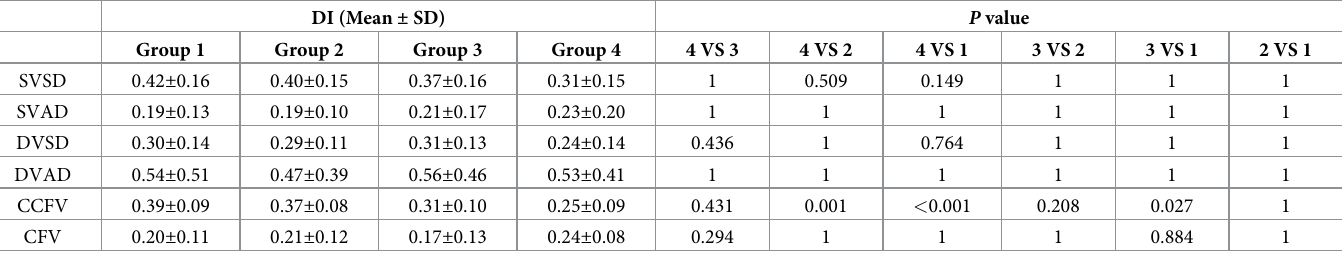
Table 4. Comparisons of DIs of OCTA parameters between diabetic retinopathy severity stage groups.